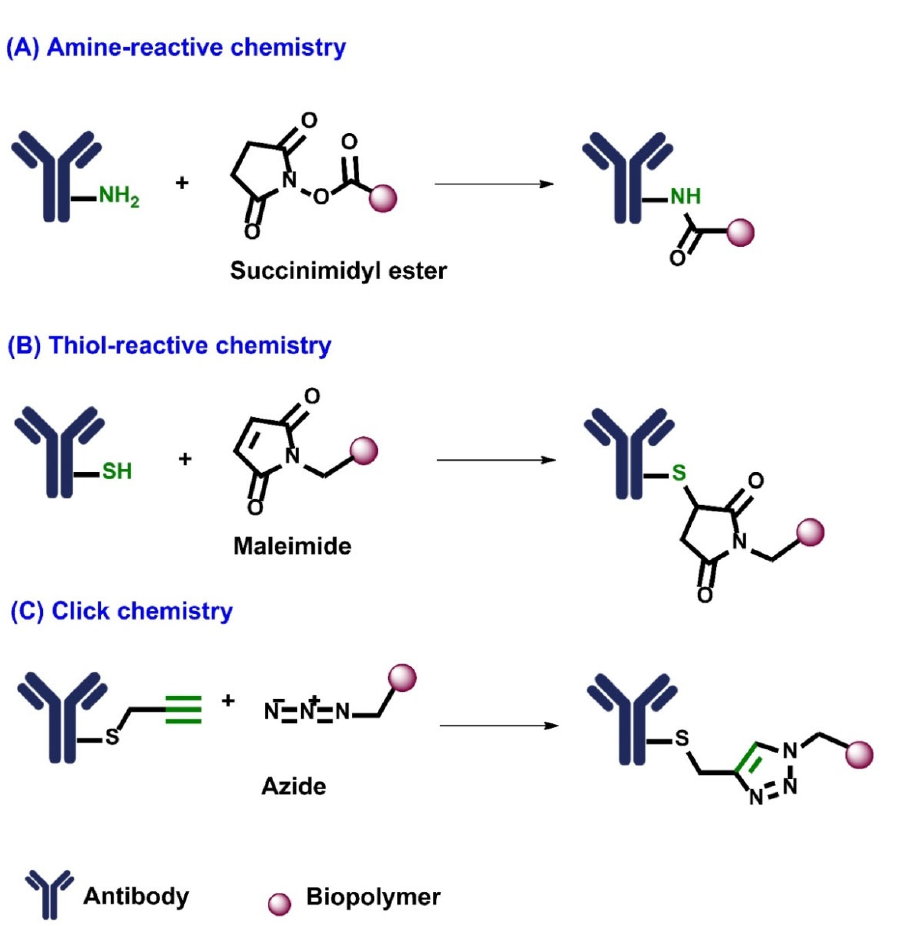
Figure 2. Bioconjugation chemistry: ( A ) amine-reactive chemistry, ( B ) thiol-reactive chemistry, ( C ) click chemistry.